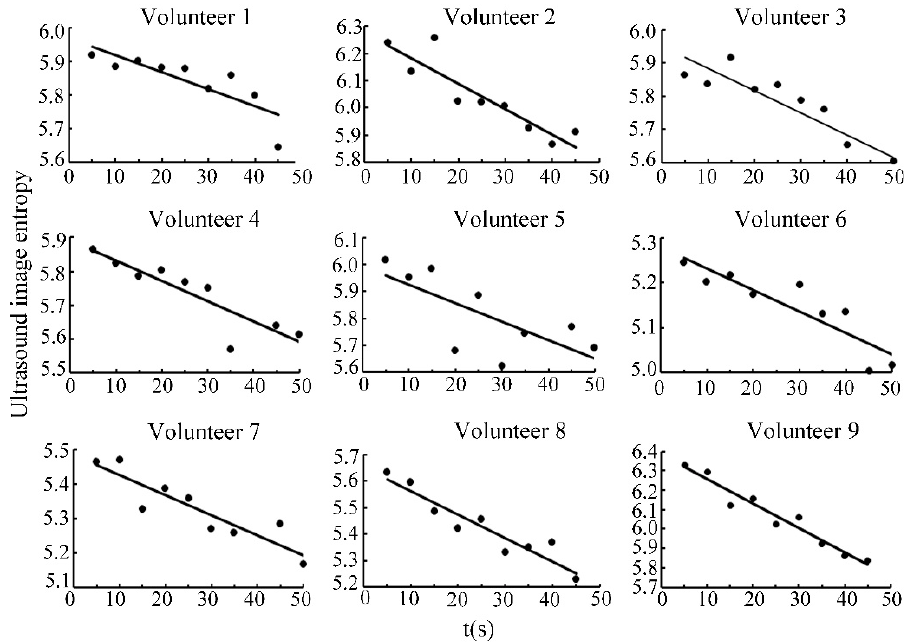
Figure 4. USIEs of each volunteer during the SC process.